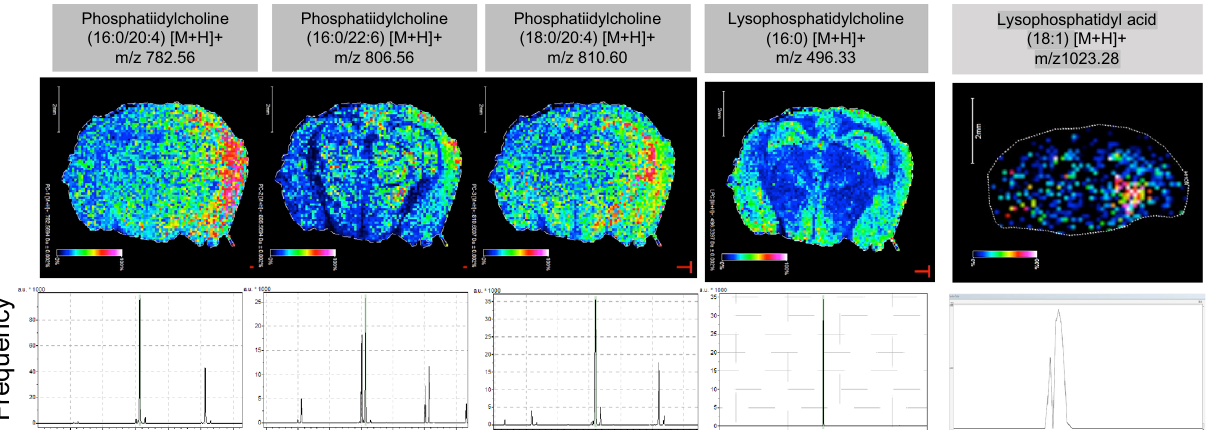
Figure 3. Images of PC, LPC and LPA in the brain RN model 1 month after irradiation. Schema of a mouse brain coronal section and ion images of phosphatidylcholines (PCs), lysophosphatidylcholine (LPC), and lysophosphatidyl acid (LPA) obtained by IMS are shown. Distributions of PCs (16:0/20:4), (16:0/22:6), and (18:0/20:4), LPC (16:0), and LPA (18:1) in brain sections of the RN model 1 month after irradiation are indicated. All data were normalized using total ion currents. A representative mass spectrum obtained from an RN mouse brain section using matrix-assisted laser desorption/ionization (MALDI)-IMS is shown for each PC, LPC, and